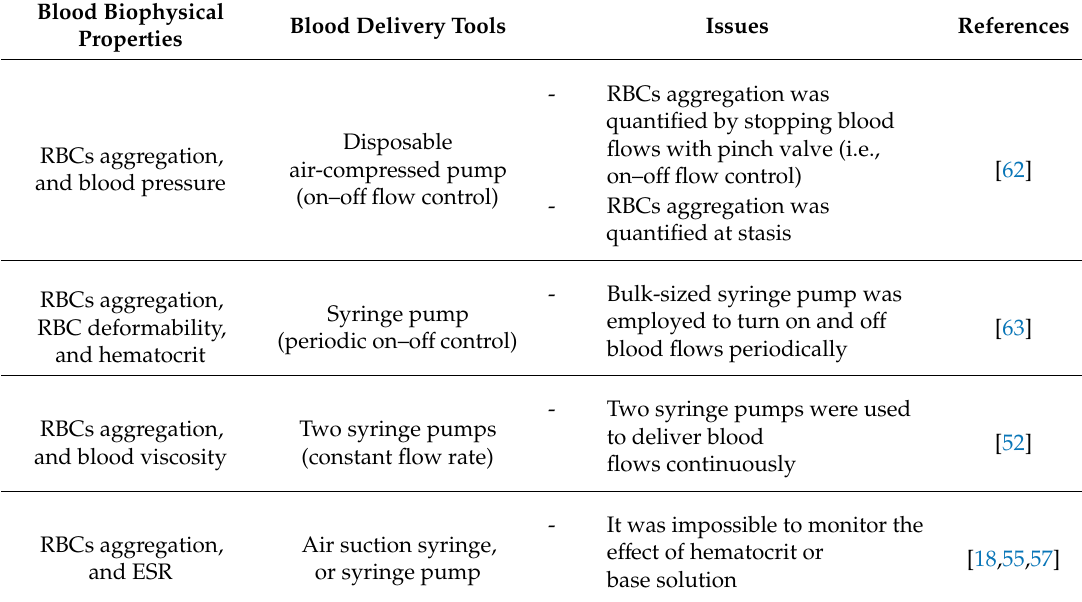
Table 1. Several issues raised in the previous measurement method of red blood cells’ (RBCs) aggregation under microfluidic environments. ESR, erythrocyte sedimentation